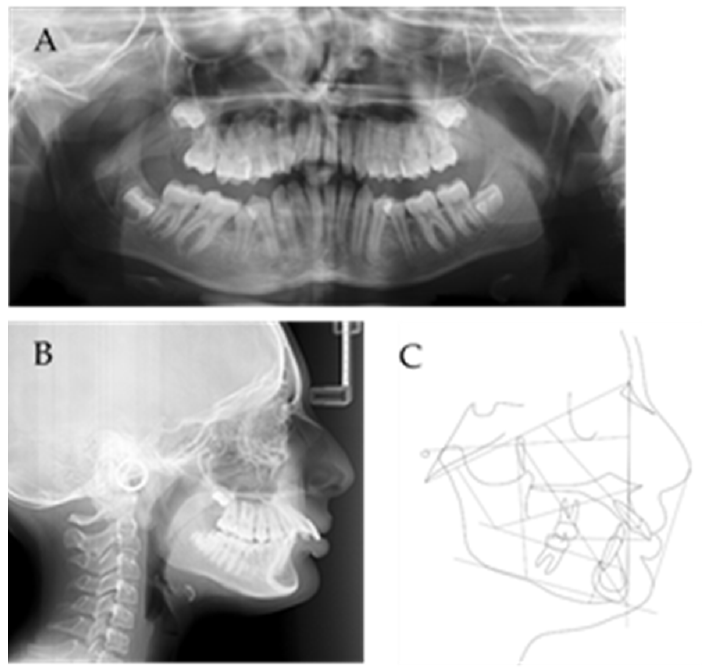
Figure 2. Initial panoramic X-ray ( A ), teleradiograph ( B ) and cephalometry ( C ).